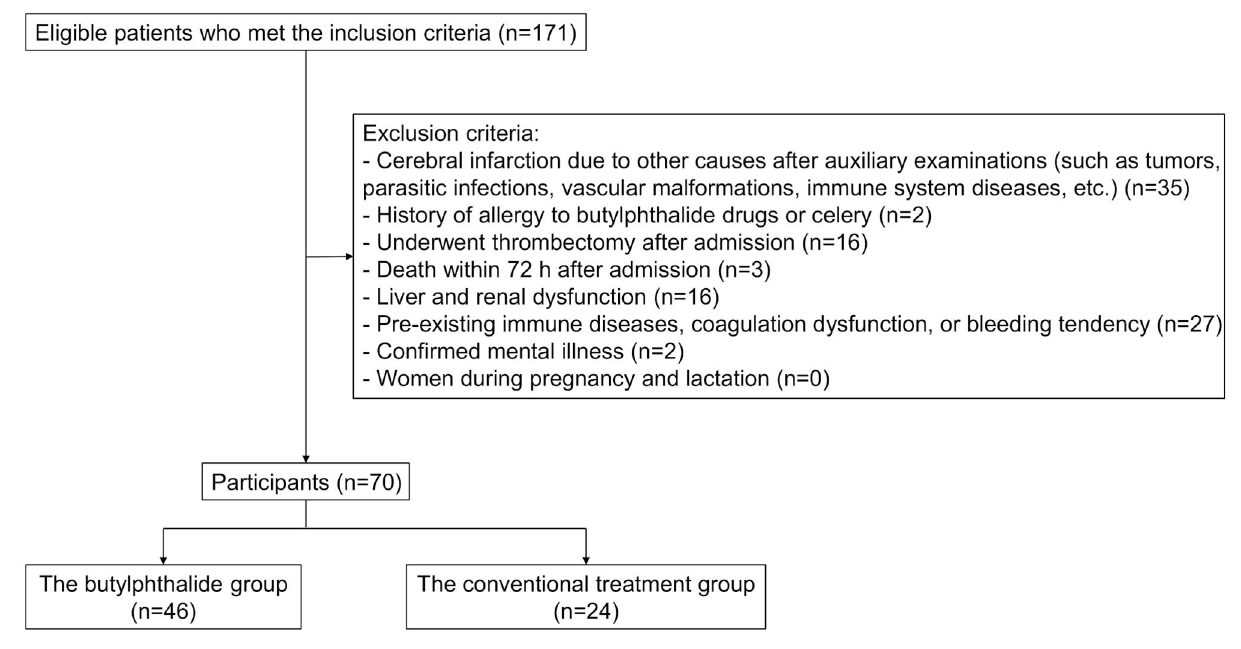
FIGURE 1 | Consort figure.